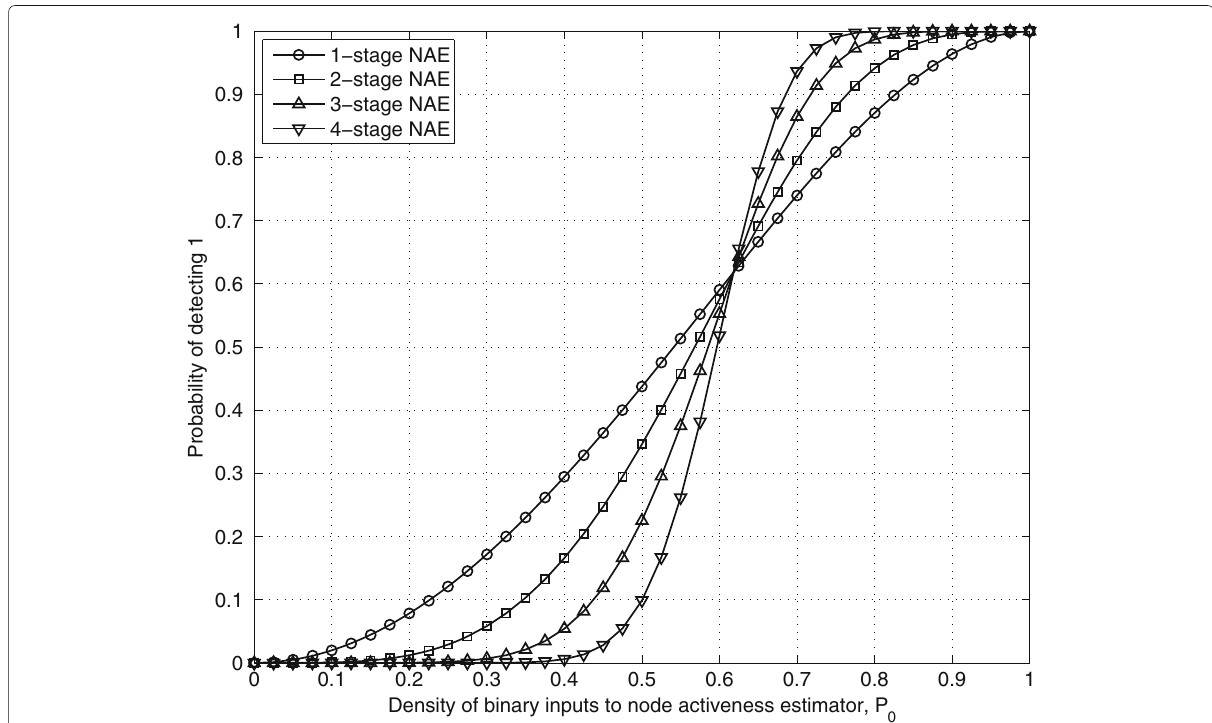
Fig. 6 Probability that the NAE detects 1 versus density of input vectors